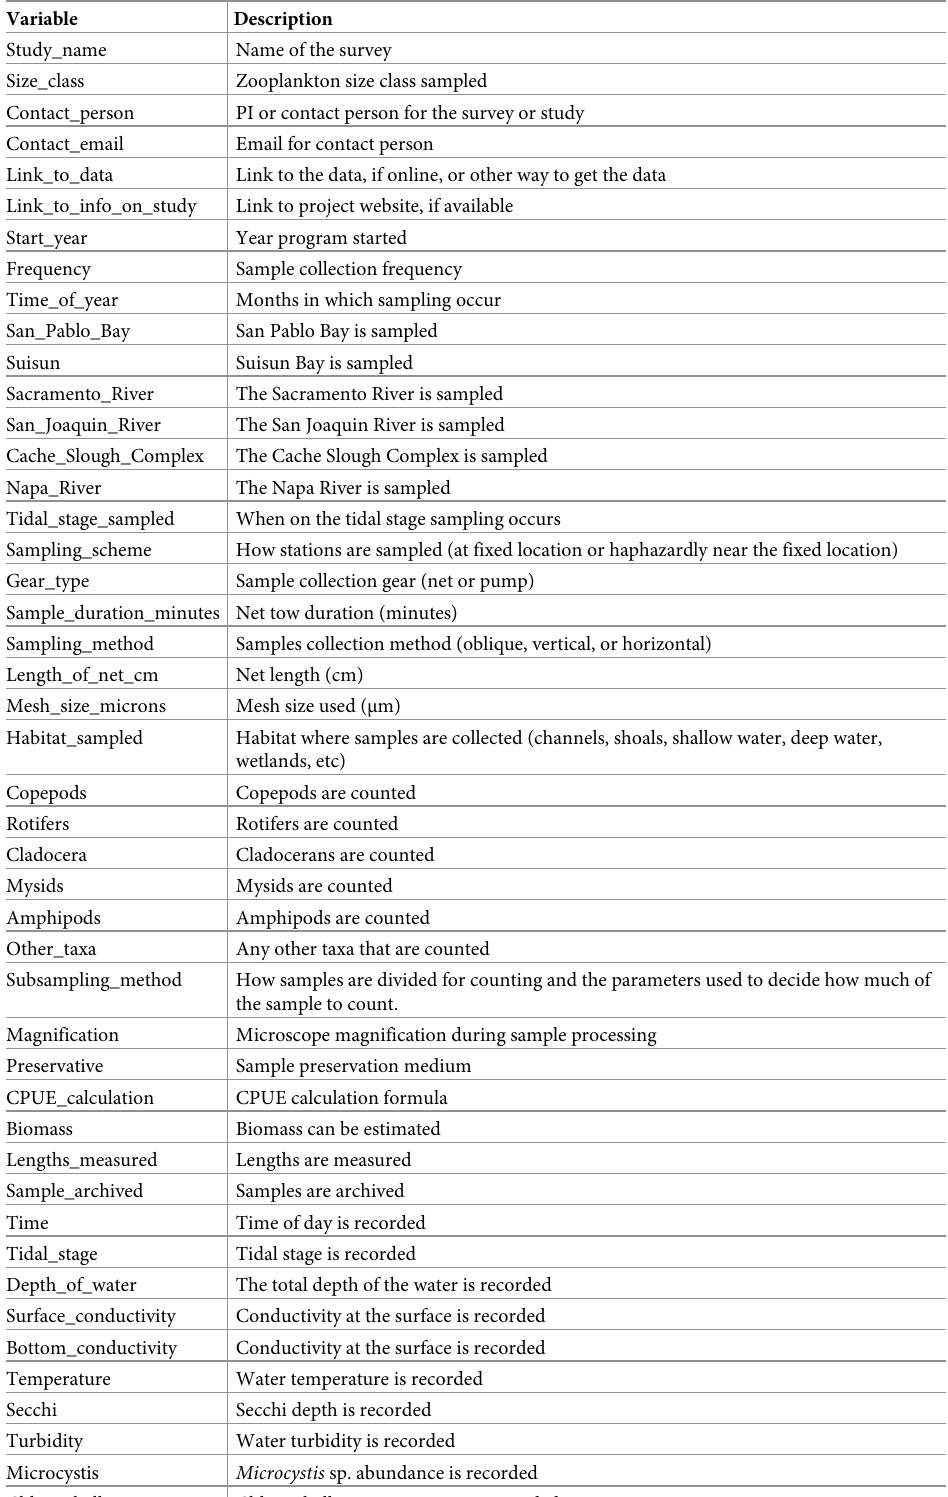
Table 4. Descriptions of variables in the study_metadata.csv